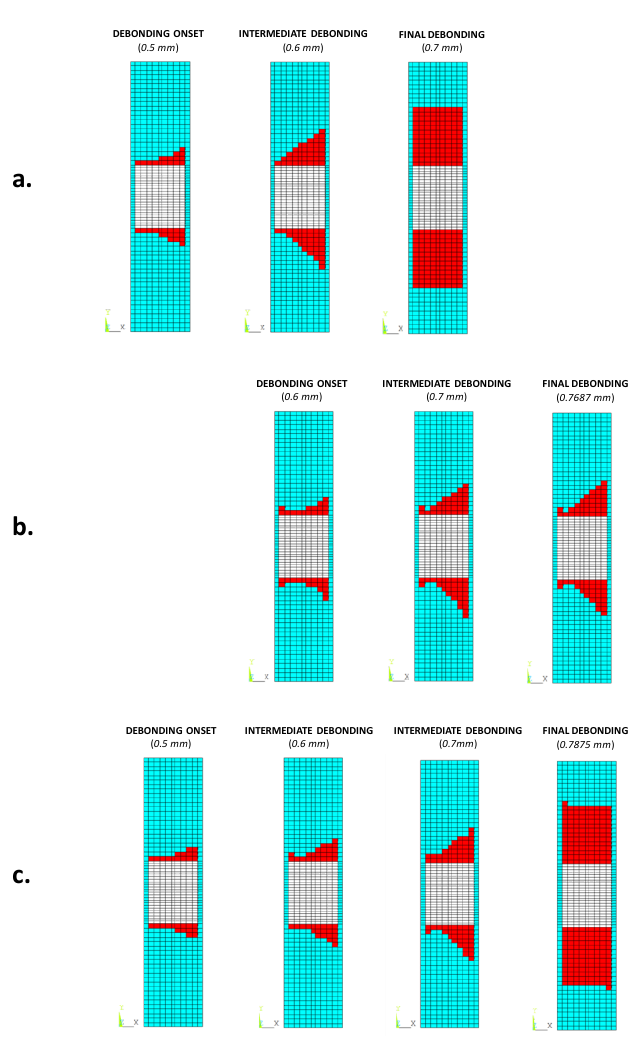
Figure 9. Delamination evolution in: ( a ) the reference material configuration; ( b ) the toughened material configuration; ( c ) the material configuration with high sensitivity to fibre bridging (SMXB).